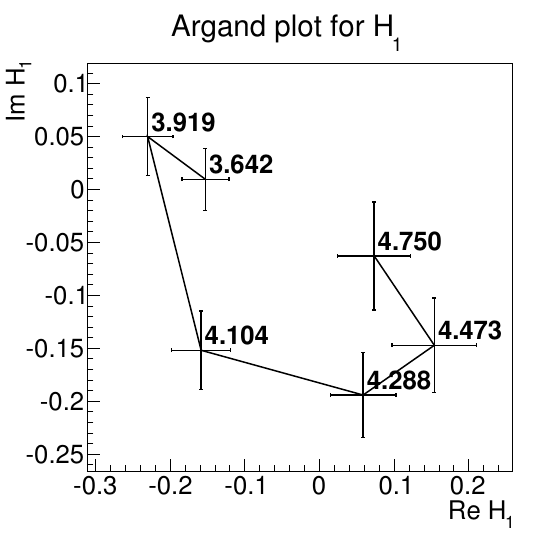
Figure 3. Argand plot for the Z c (4200) + helicity amplitude H 1 . The bin central mass values (in GeV / c 2 ) are shown near the points. Figure from reference